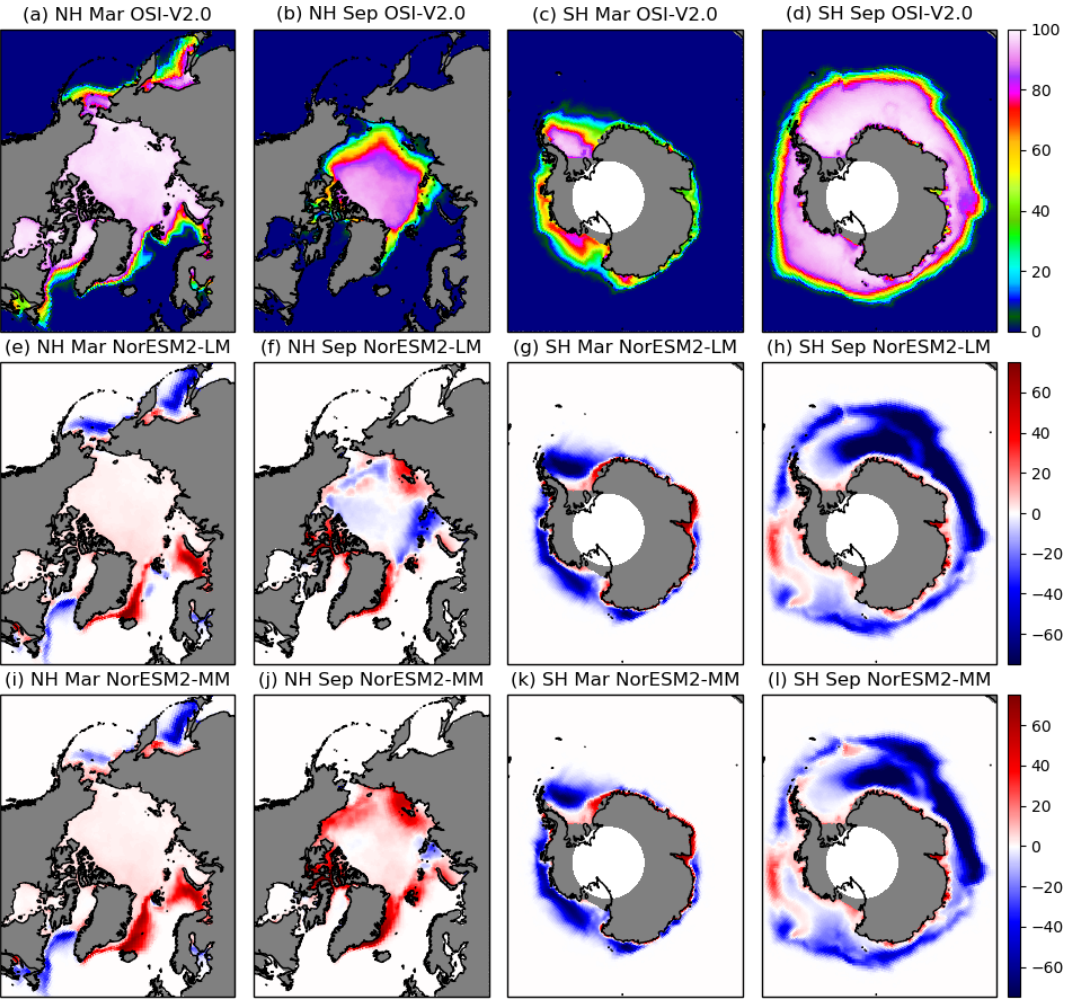
Figure 12. Sea-ice concentration from OSISAF observations (OSI-V2.0; Lavergne et al., 2019) in March (a, c) and September (b, d) for the Northern Hemisphere (a, b) and Southern Hemisphere (c, d) . Differences between model ensemble means and observations for the respective hemisphere and months are shown for NorESM2-LM (e–h) , and NorESM2-MM (i–l) . Model and observations are monthly means for the period 1980–2009. Units are